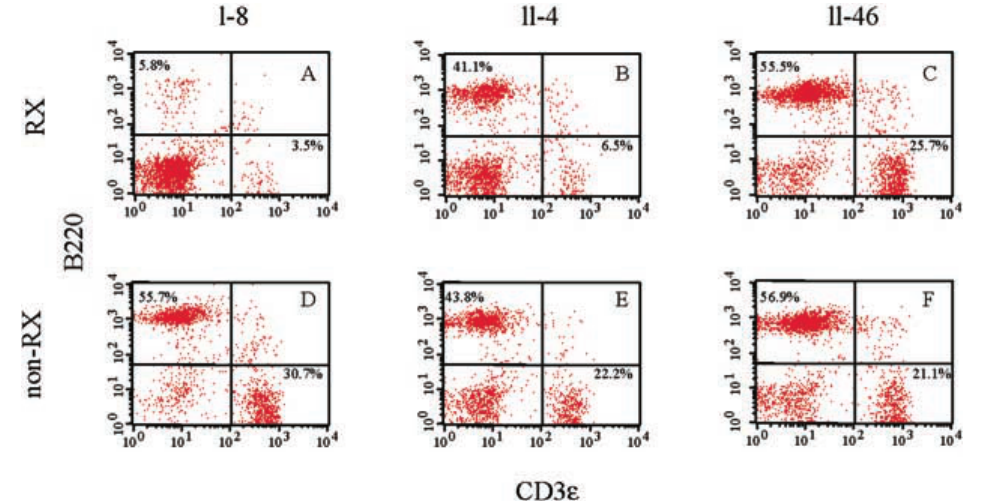
FIGURE 1 Reduction and reconstitution of B and T cell numbers in RX-P.S. following irradiation. Splenocytes were isolated from A–C, RX-P.S. and D–F, non-RX mice 8 days after primary immunization (A, D) with NP-KLH precipitated in Alum and 4 (B, E) and 46 days (C, F) after the second stimulation with NP-KLH in PBS. B220 and CD3 1 single positive cell are defined as B cells and T cells,